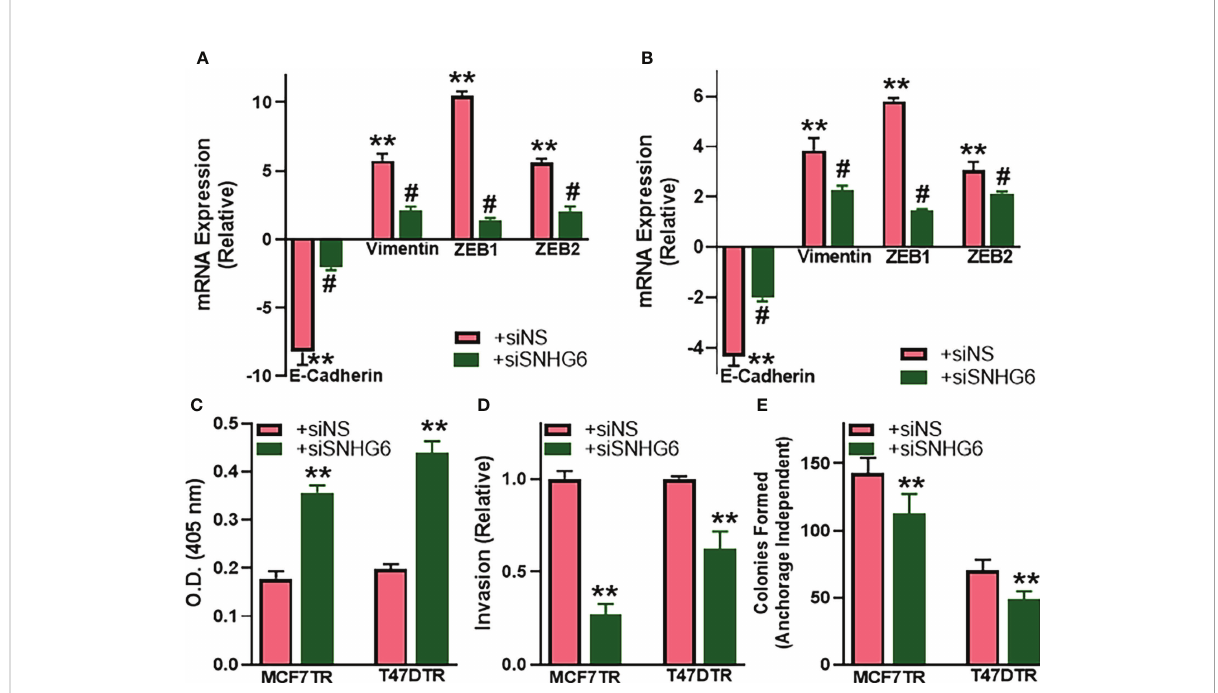
FIGURE 2 SNHG6 affects EMT, apoptosis, invasion and clonogenicity. (A) MCF7TR and (B) T47DTR cells were transfected with control siRNA (siNS) or siRNA against SNHG6 and then the levels of EMT markers, E-cadherin, vimentin, ZEB1 and ZEB2 were evaluated by qRT-PCR. The levels of these markers in respective parental cells were assigned a value of 1 and the relative levels in siNS/siSNHG6 transfected tamoxifen-resistant cells are plotted. (C) Apoptosis was assessed in tamoxifen-resistant cells by Histone/DNA ELISA method, as described in the Methods, by measuring the O.D. at 405 nm. (D) Invasive potential of tamoxifen-resistant cells was evaluated by quantitating the fl uorescence of cells that invaded through the matrigel-coated membranes. Fluorescence of siNS cells assigned a value of 1 and the relative fl uorescence of siSNHG6 transfected tamoxifen-resistant cells is plotted. (E) Clonogenicity was measured by counting the colonies formed by cells in an anchorage-independent manner, as described in the Methods. **p<0.01, compared to respective controls, #p<0.01, compared to